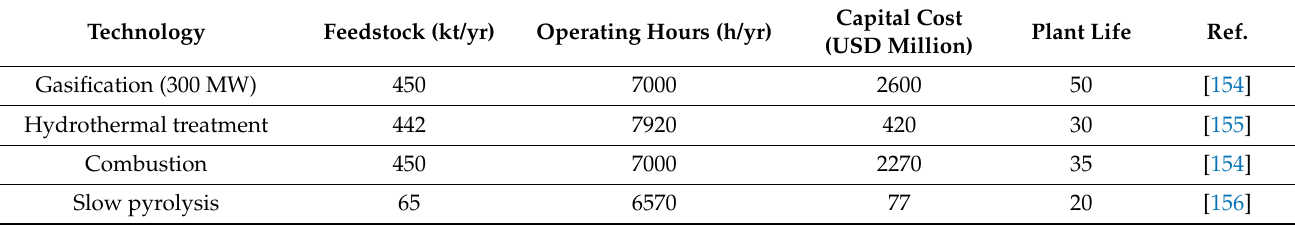
Table 4. Financial assumptions for the hydrothermal treatment.